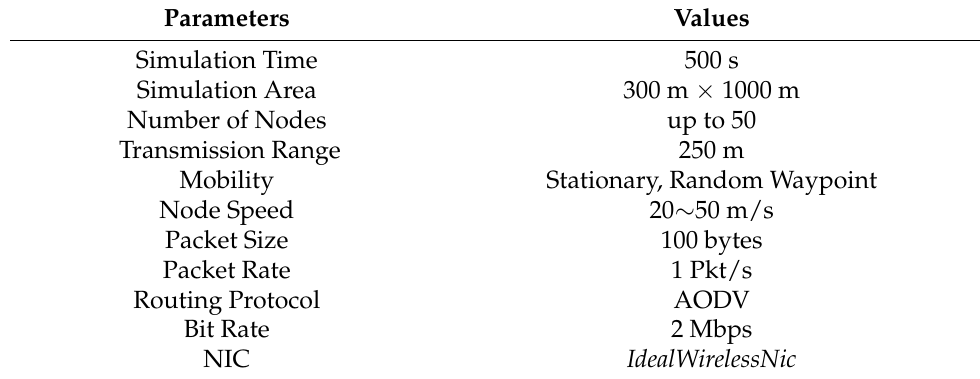
Table 1. Network